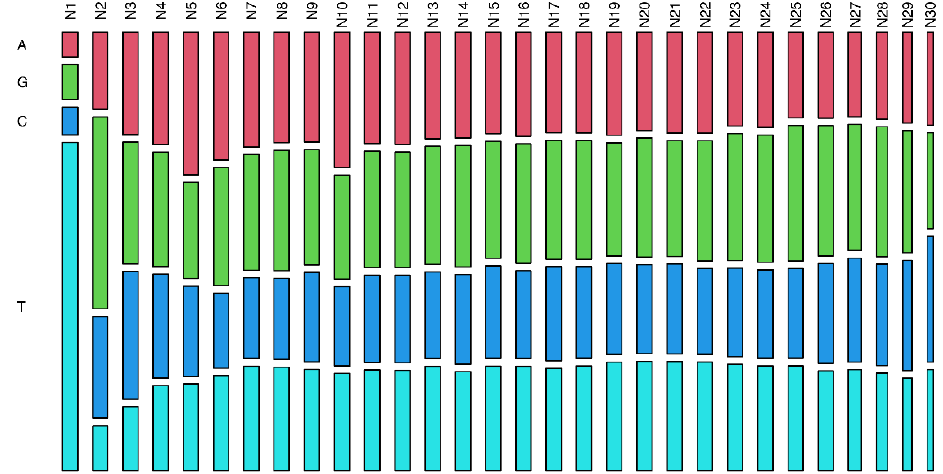
Figure 4. Frequency of each nucleotide base along with piRNA transcripts. The analyzed distribu- tion of the nucleotides by position showed a preference for base U in the first position (79%), G in the second position (46%), and base A in the 10th position (33%).